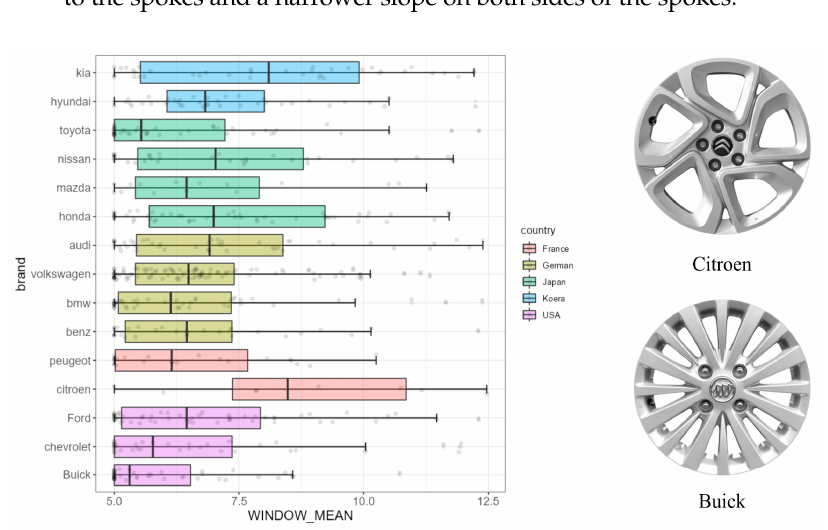
Figure 19. Window distance based on different brands. The x-axis is the average of the window-to- spoke distance and the y-axis is the brand. The larger the value, the wider the slope on either side of the spoke. In the graph, Citroen has a wider slope, while Buick has a narrower slope.